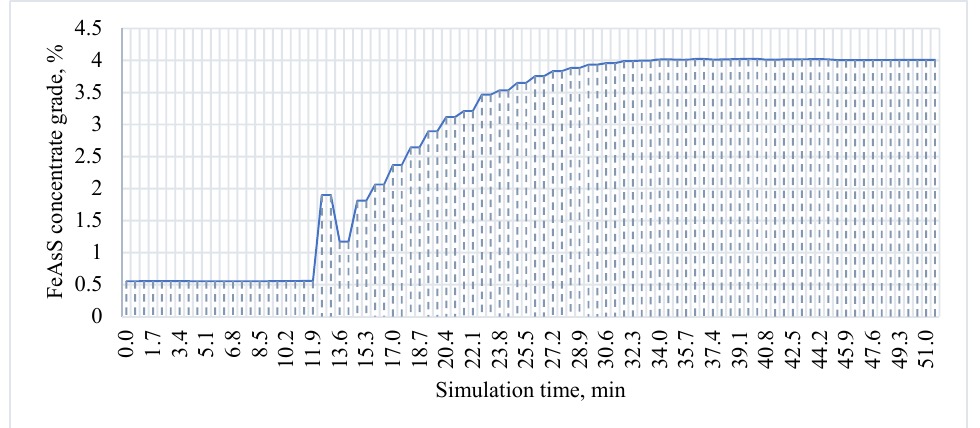
Figure 10. FeAsS concentrate grade.